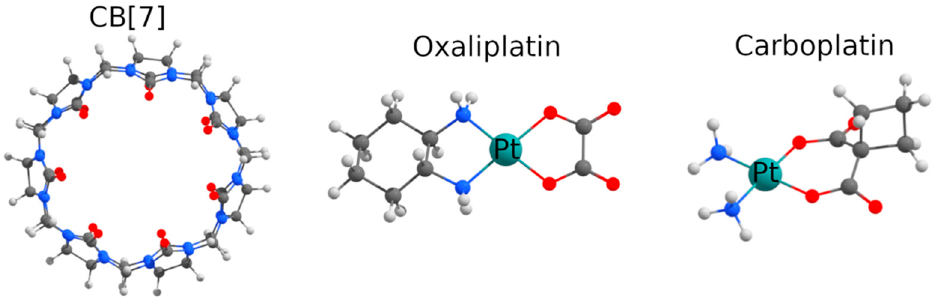
Figure 1. Molecular structures of CB[7], oxaliplatin and carboplatin.